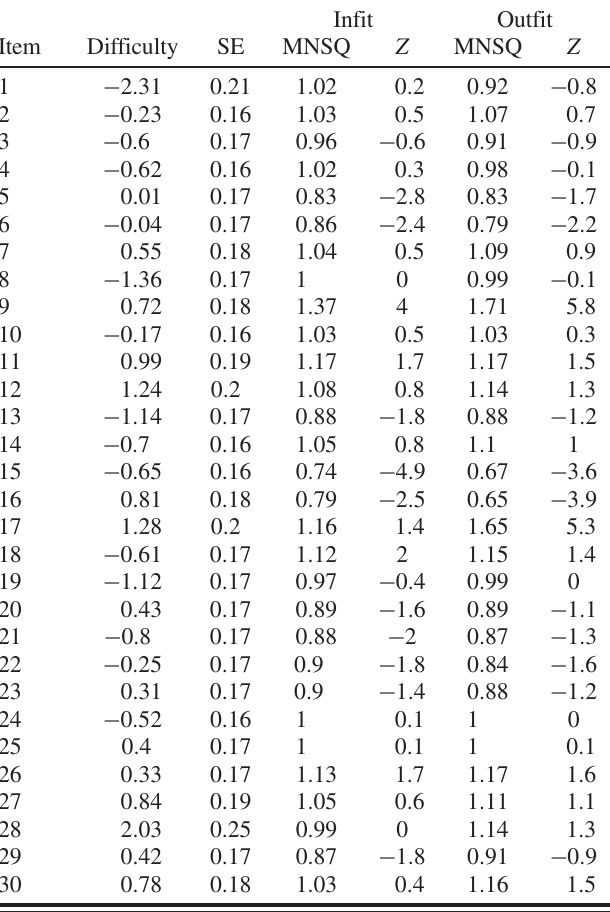
standard errors (SE), and infit and outfit statistics [mean square residuals (MNSQ) and Z